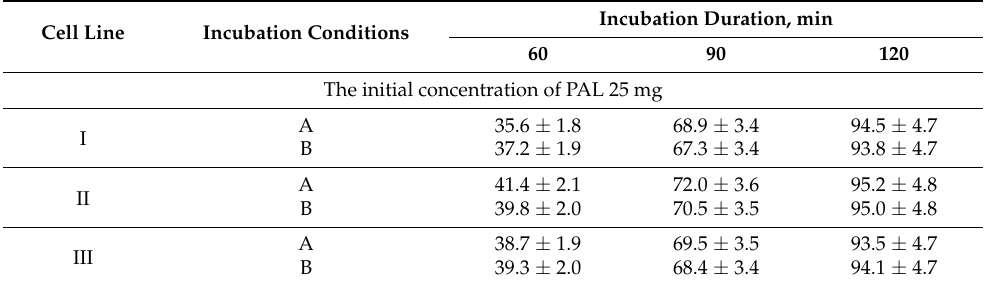
Table 1. PAL content (%) in the basolateral compartment of test systems based on Huh-7 and THP-1 cell monolayers.